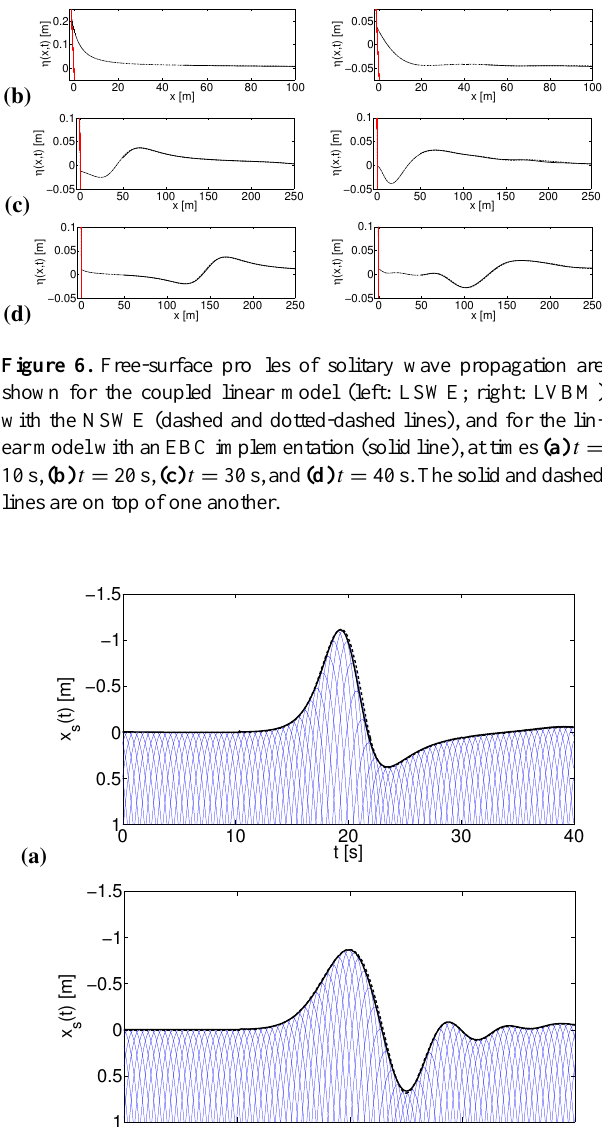
Fig. 6. Free-surface profiles of solitary wave propagation are shown for the coupled linear model (left: LSWE, right: LVBM) with the NSWE (dashed and dotted-dashed lines), and for the linear model with an EBC implementation (solid line), at times (a) t = 10s , (b) t = 20s , (c) t = 30s , (d) t = 40s . The solid and dashed lines are on top of another.